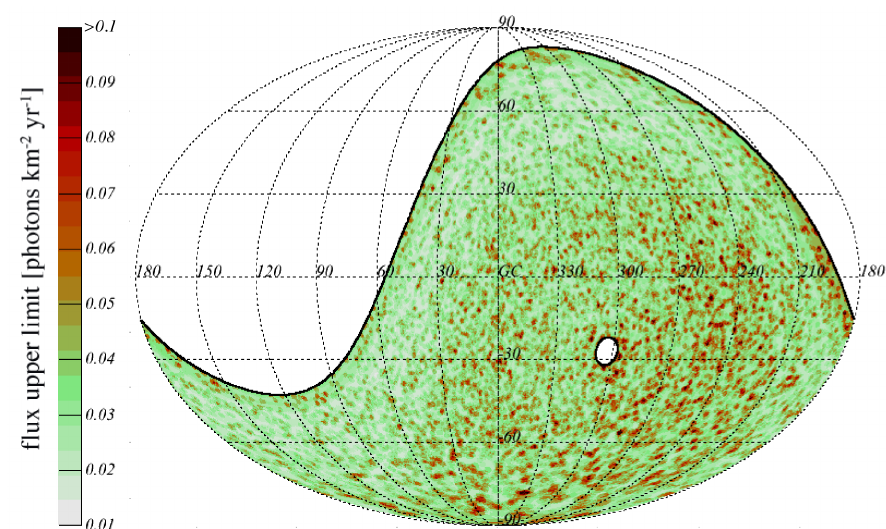
Figure 7. Celestial map, in Galactic coordinates, of upper limits on the incoming photon flux [42]. The white regions indicate regions of the sky that are either not in the field of view of the Pierre Auger Observatory (northern hemisphere) or omitted in this analysis (southern celestial pole). For more details, see [42].